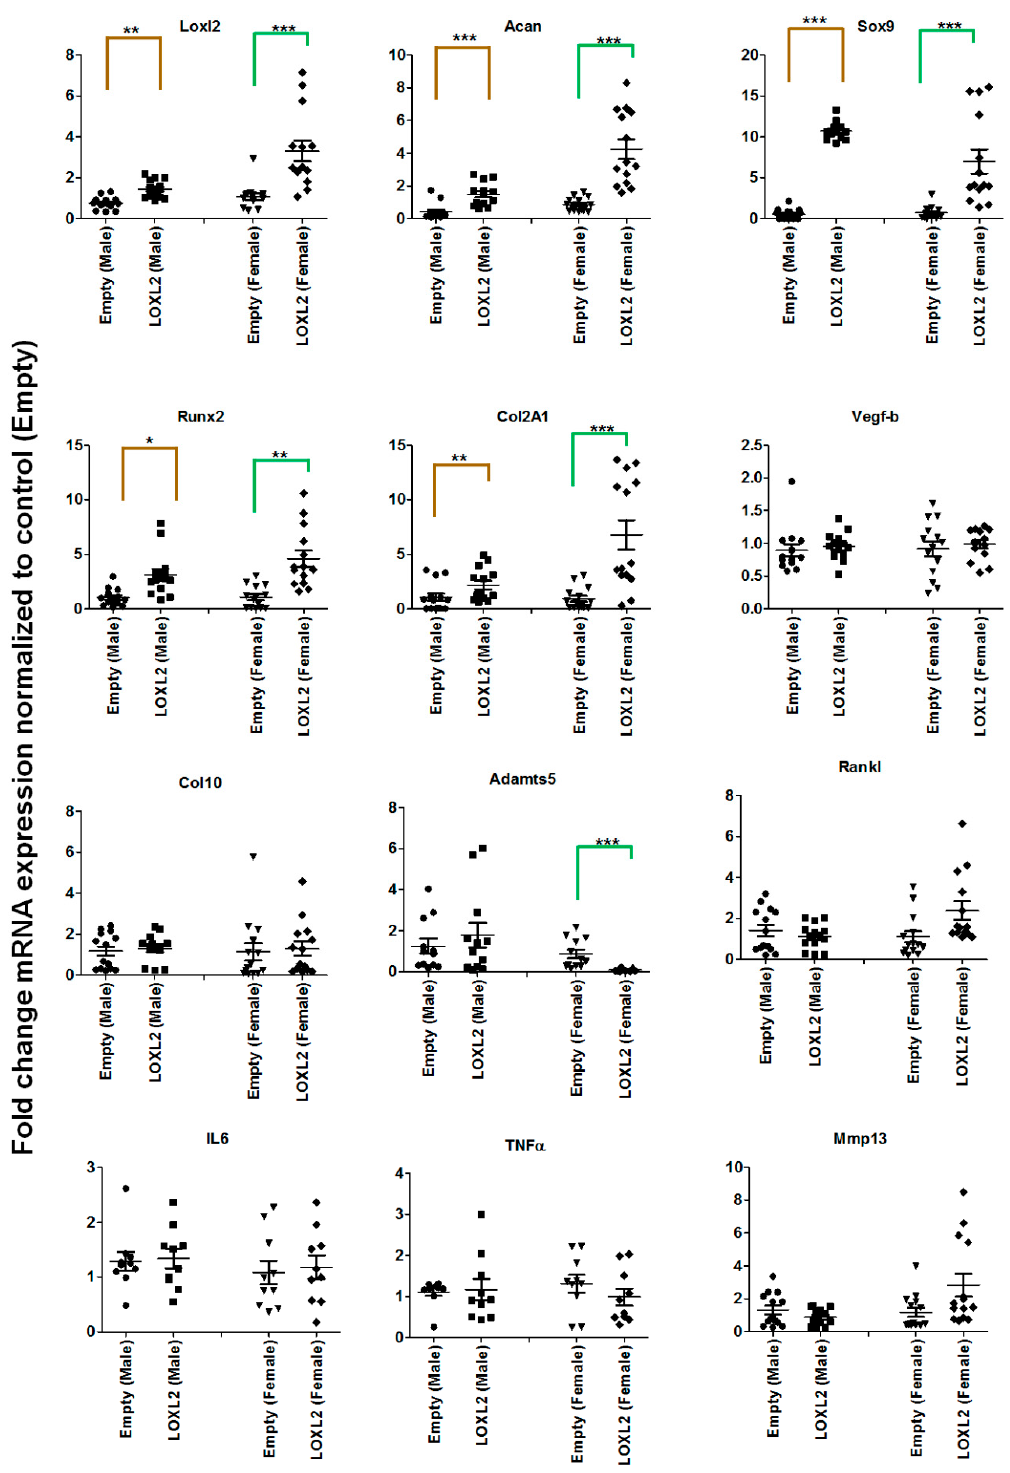
Figure 2. LOXL2 induces mRNA expression of anabolic genes in the Cho /+ mouse model. Each panel shows fold-change in mRNA levels of di ff erentially regulated genes in male and female Cho /+ mice injected with Adv-RFP-Empty (dot-male; triangle- female) and Adv-RFP-LOXL2 (square-male; rhombus-female). The statistically significant di ff erences between groups for males (gold color line) and females (green color line) were evaluated by two-way ANOVA with Bonferroni correction (* represent significant di ff erences; * p < 0.05, ** p < 0.01, and *** p < 0.001;